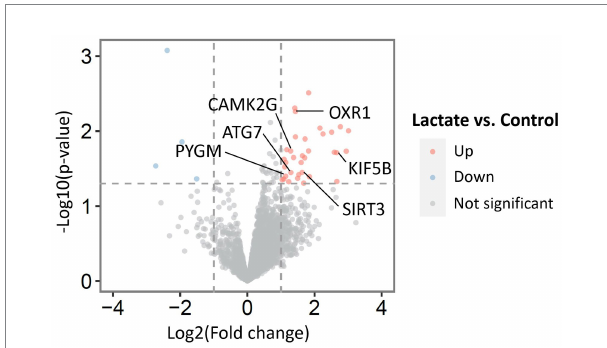
FIGURE 1 Volcano plot with all identified proteins from proteomic analysis of HPC of L-lactate treated rats and ACSF treated rats. Thirty four upregulated and four downregulated proteins were found in lactate group compared to